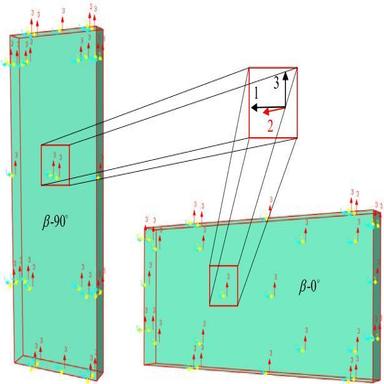
Plates with different material directions, (a) plates on α plane, (b) plates on β plane, (c) plates on λ plane.